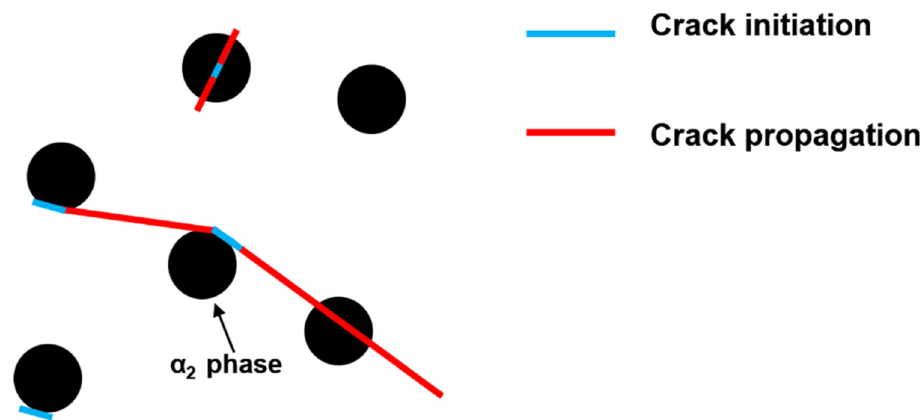
Figure 16. The schematic diagram of the initiation and propagation of the crack [36].